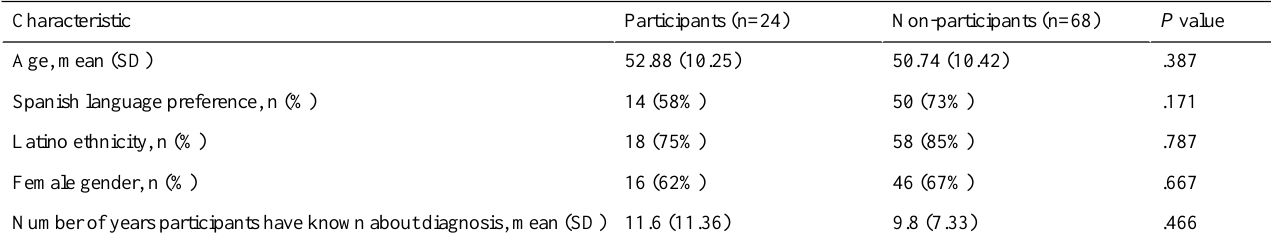
Table 2. Focus group participant and non-participant